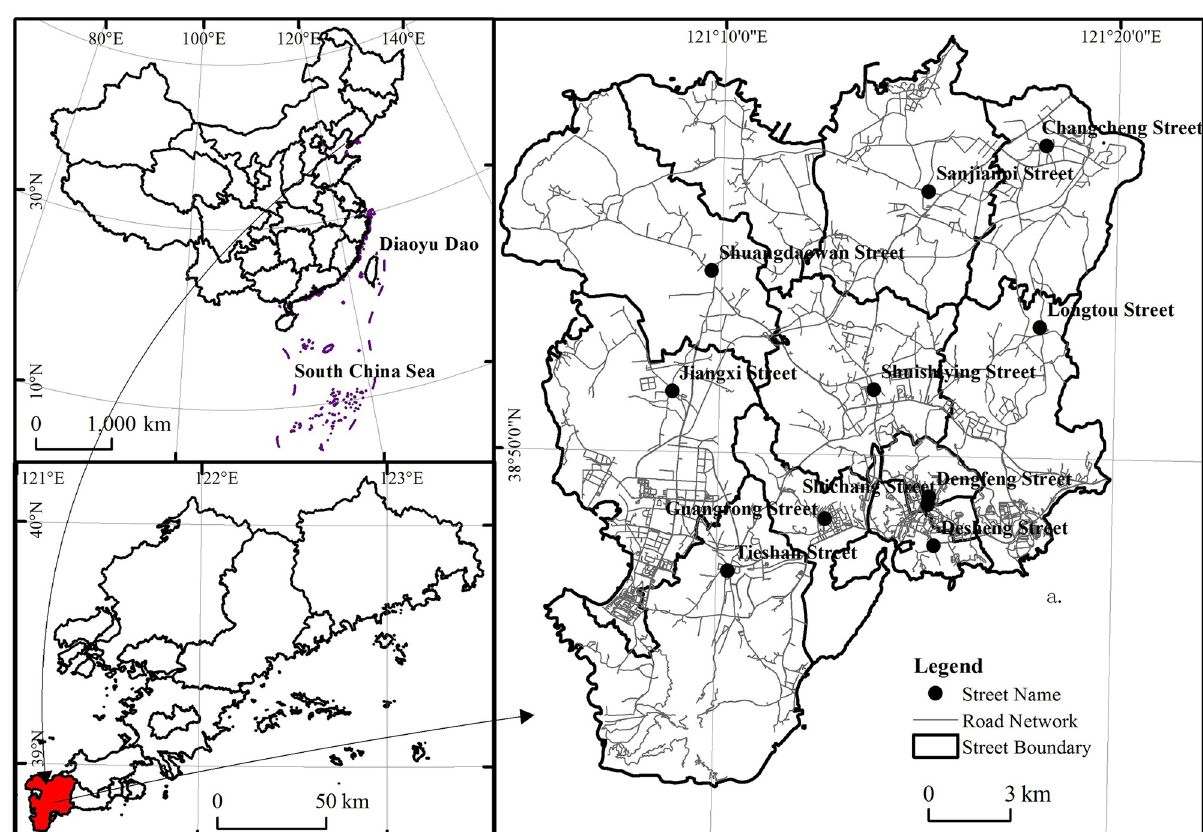
Fig 1. Location and study area: Lushunkou District, in the city of Dalian in Liaoning Province, China.